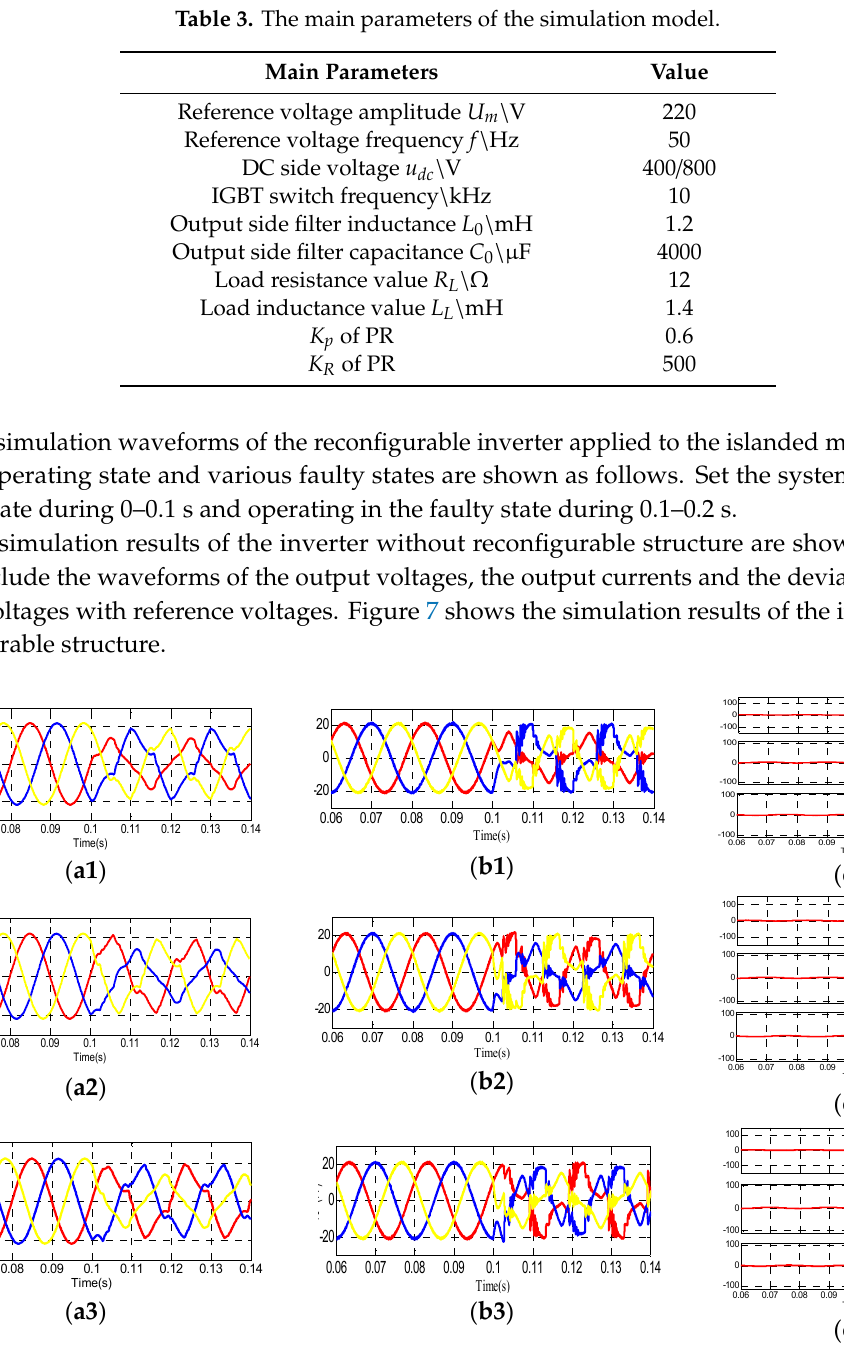
Figure 6. Simulation results of the non-reconfigurable inverter: ( a1 ) output voltages under faulty phase a; ( a2 ) output voltages under faulty phase b; ( a3 ) output voltages under faulty phase c; ( b1 ) currents under faulty phase a; ( b2 ) currents under faulty phase b; ( b3 ) currents under faulty phase c; ( c1 ) voltage deviations under faulty phase a; ( c2 ) voltage deviations under faulty phase b; ( c3 ) voltage deviations under faulty phase c.